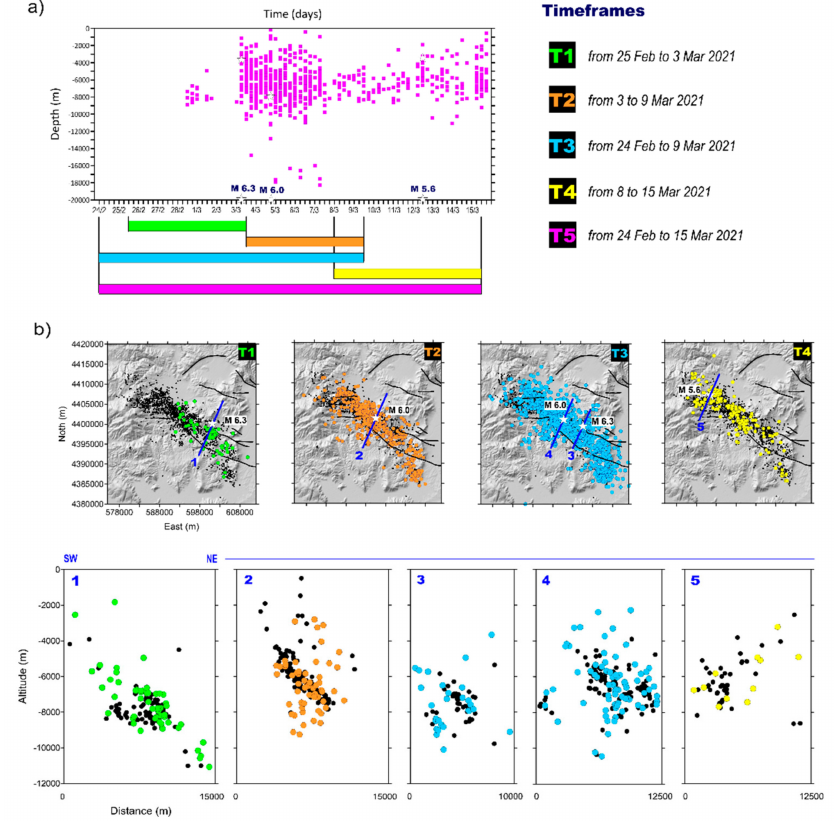
Figure 2. Seismicity evolution. ( a ) Depth vs. time plot of the seismicity occurred between 28 February 2021 and 15 March 2021; some timeframes used in the subsequent discussion are also shown in different colors (T). ( b ) Maps and sections of the relocated seismicity plotted according to their origin time. Black dots are the relocated earthquakes recorded until 26 April 2021; subsequent earthquakes are shown with colors reflecting the introduced timeframes (from green to yellow circles). The three largest events are represented by white stars in the upper